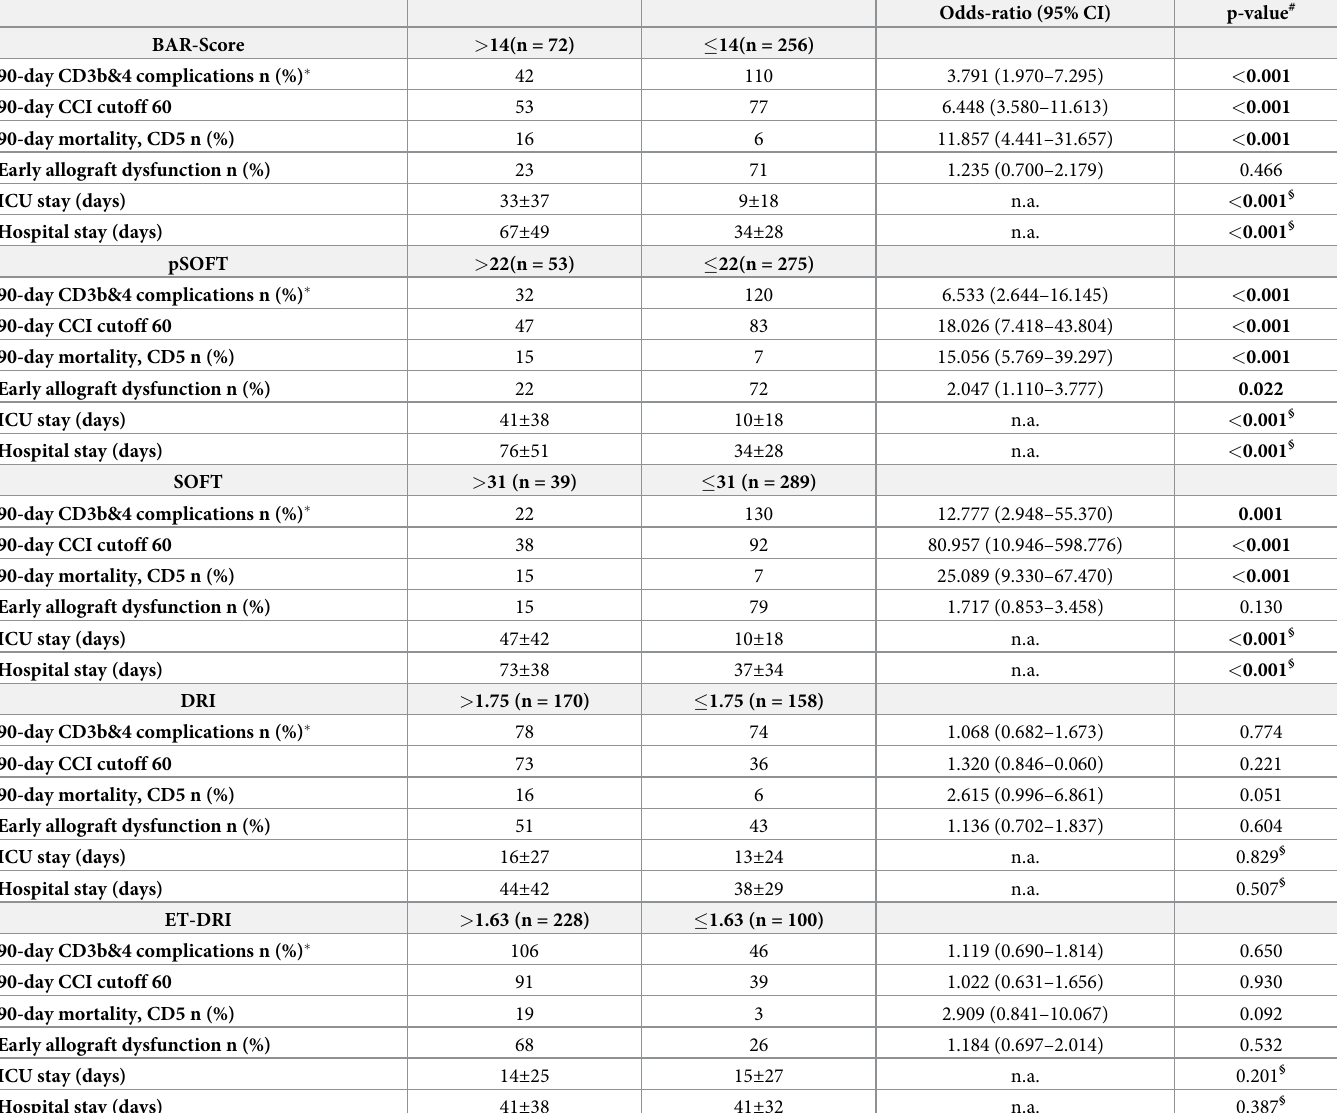
Table 6. Stratification of the postoperative outcome based on the determined BAR, pSOFT, SOFT, DRI and ET-DRI cutoffs.